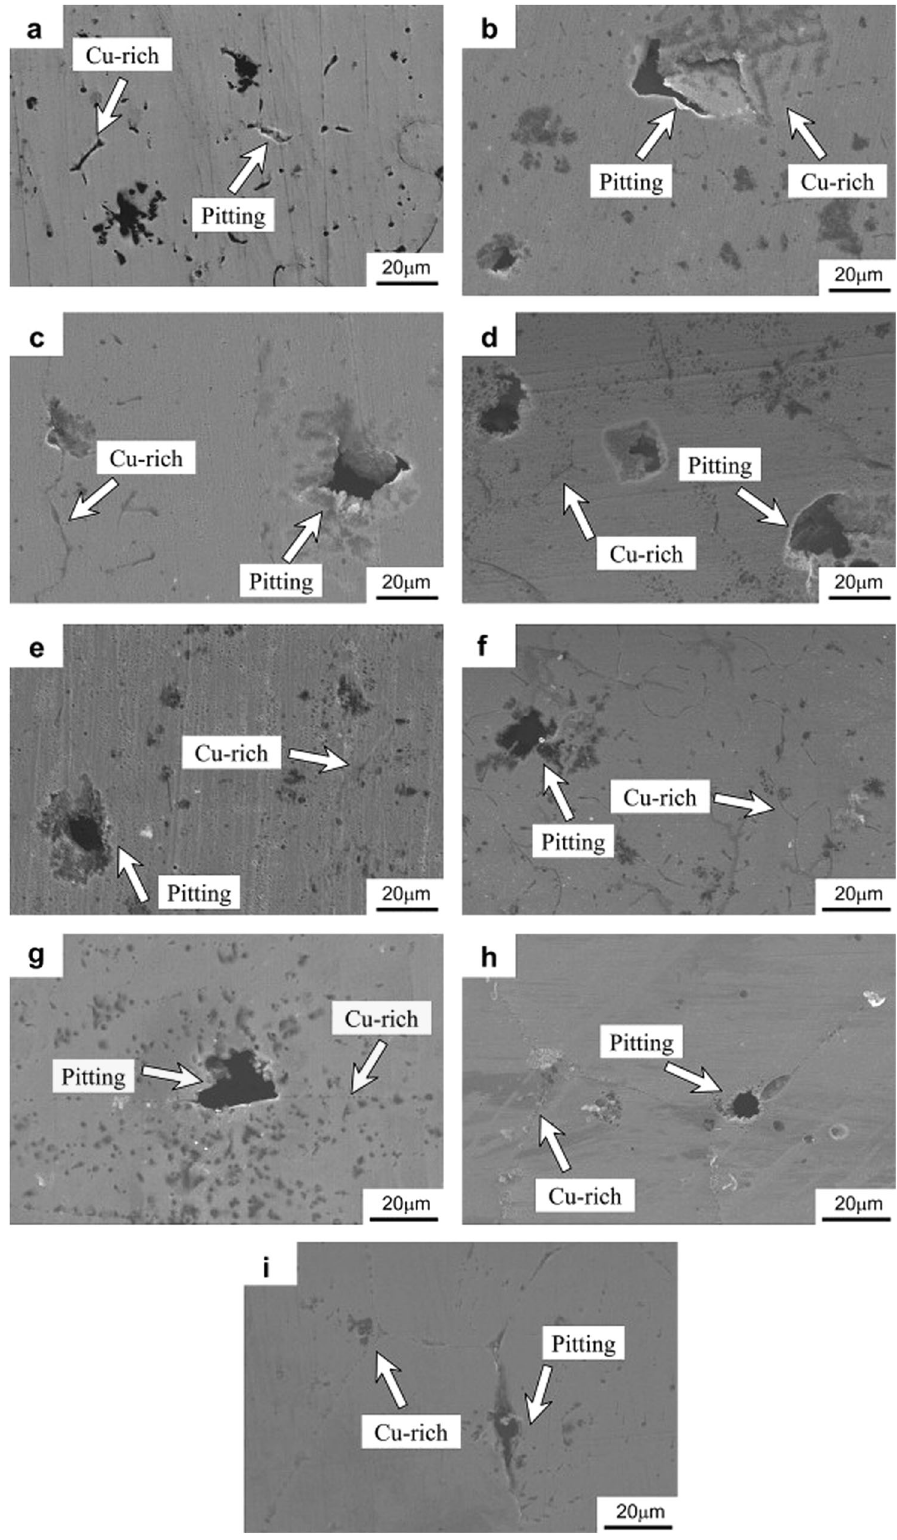
Fig. 11 Surface morphology of as-cast and aged Cu 0.5 CoCrFeNi alloys after potentiodynamic polarisation testing in 3.5% NaCl at 25 °C: a as- cast, b 350 °C, c 500 °C, d 650 °C, e 800 °C, f 950 °C, g 1100 °C, h 1250 °C, i 1350°C ( a – i reprinted from ref. 60 with permission from Elsevier)